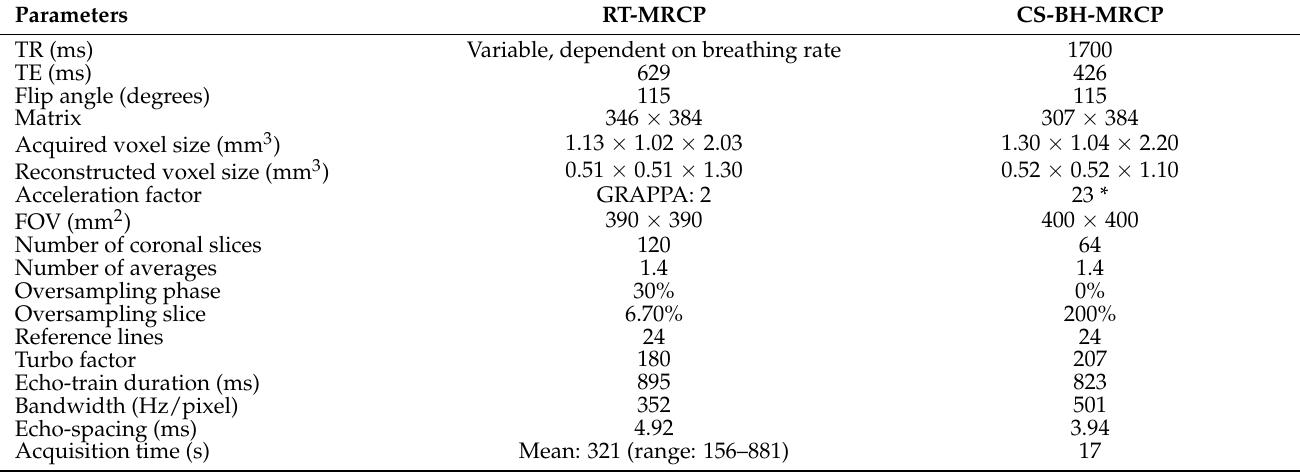
Table 1. Acquisition parameters of the conventional RT-MRCP and prototype CS-BH-MRCP